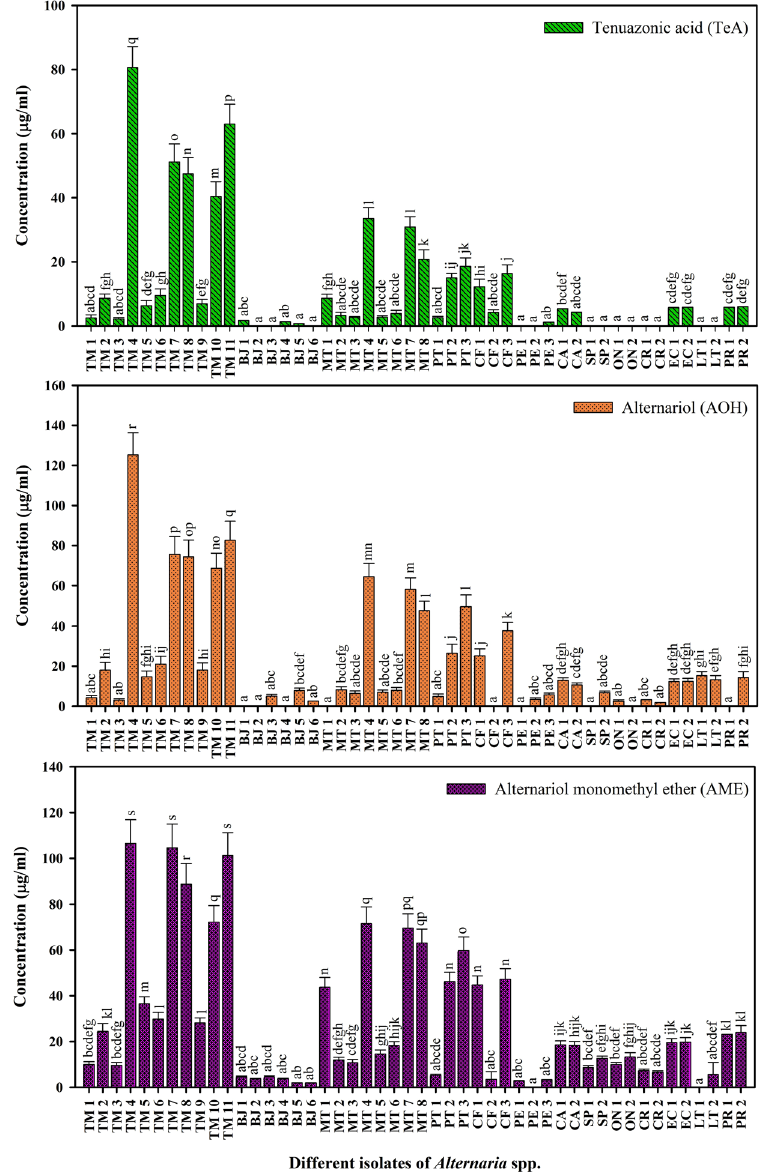
Figure 6. Graphical representation of different mycotoxins (TeA, AOH and AME) and their varying concentrations from 48 selected pathogenic isolates of Alternaria . Results are expressed in mean of three replicates and vertical bars show the ± SD of the